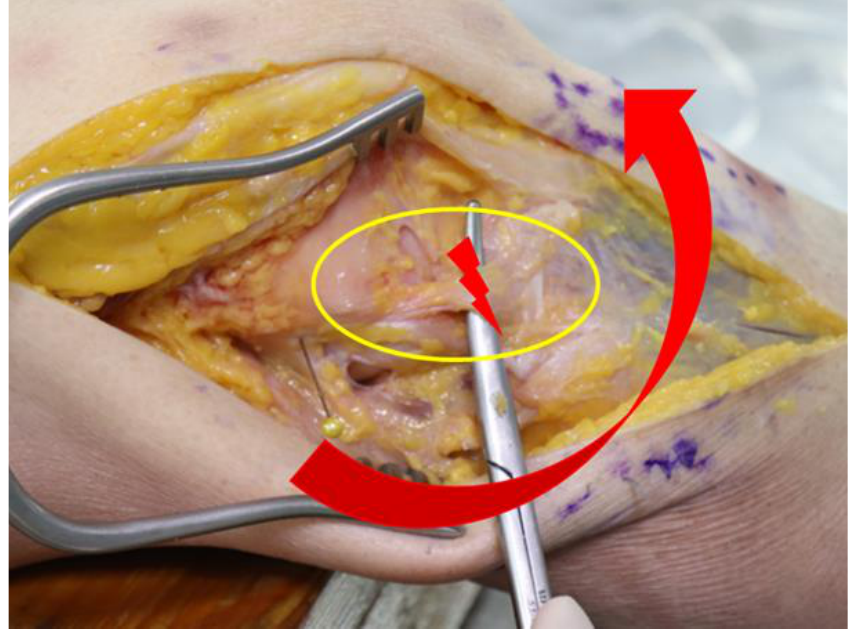
Figure 2. Resection of anterolateral ligament increases anterolateral rotatory instability in anterior cruciate ligament-deficient knees.